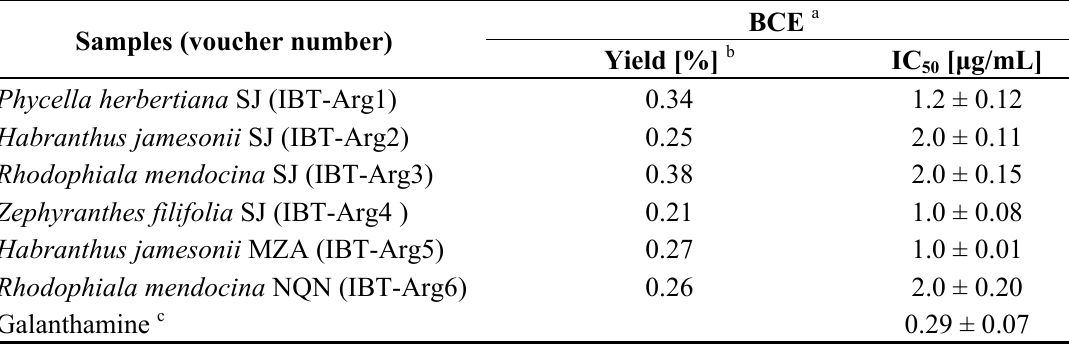
Table 1. Acetylcholinesterase Enzyme Inhibition of Wild Argentinian Amaryllidaceae [ μ extracts expressed as IC 50